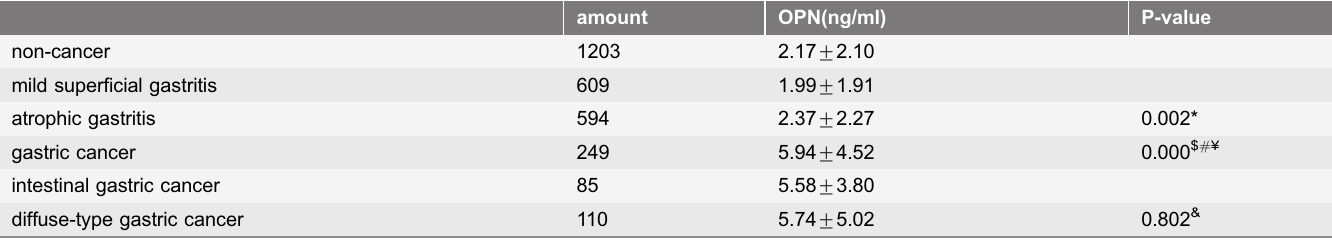
Table 2. Levels of serum OPN (mean ¡ SD) between different gastric disease groups.